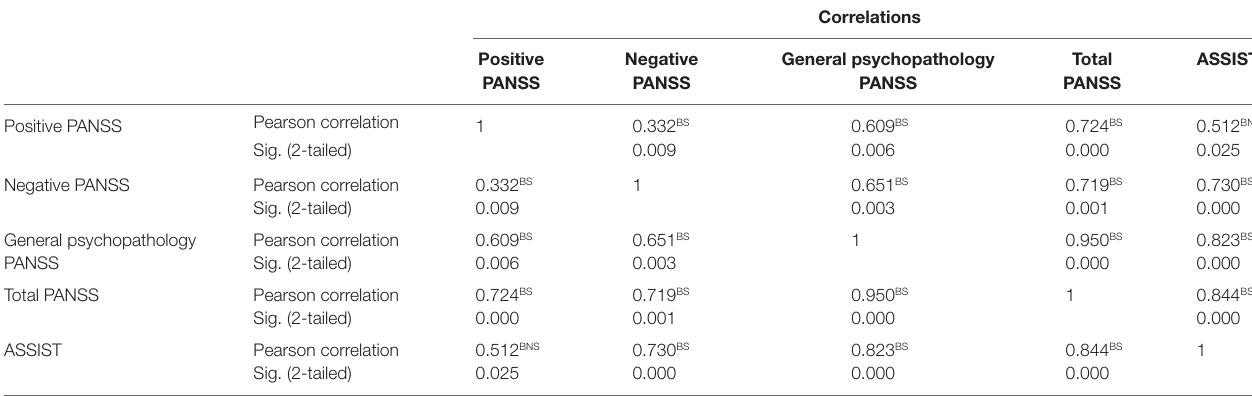
TaBle 4 | correlation between assisT scores and positive and negative symptoms scale in schizophrenia ( N =